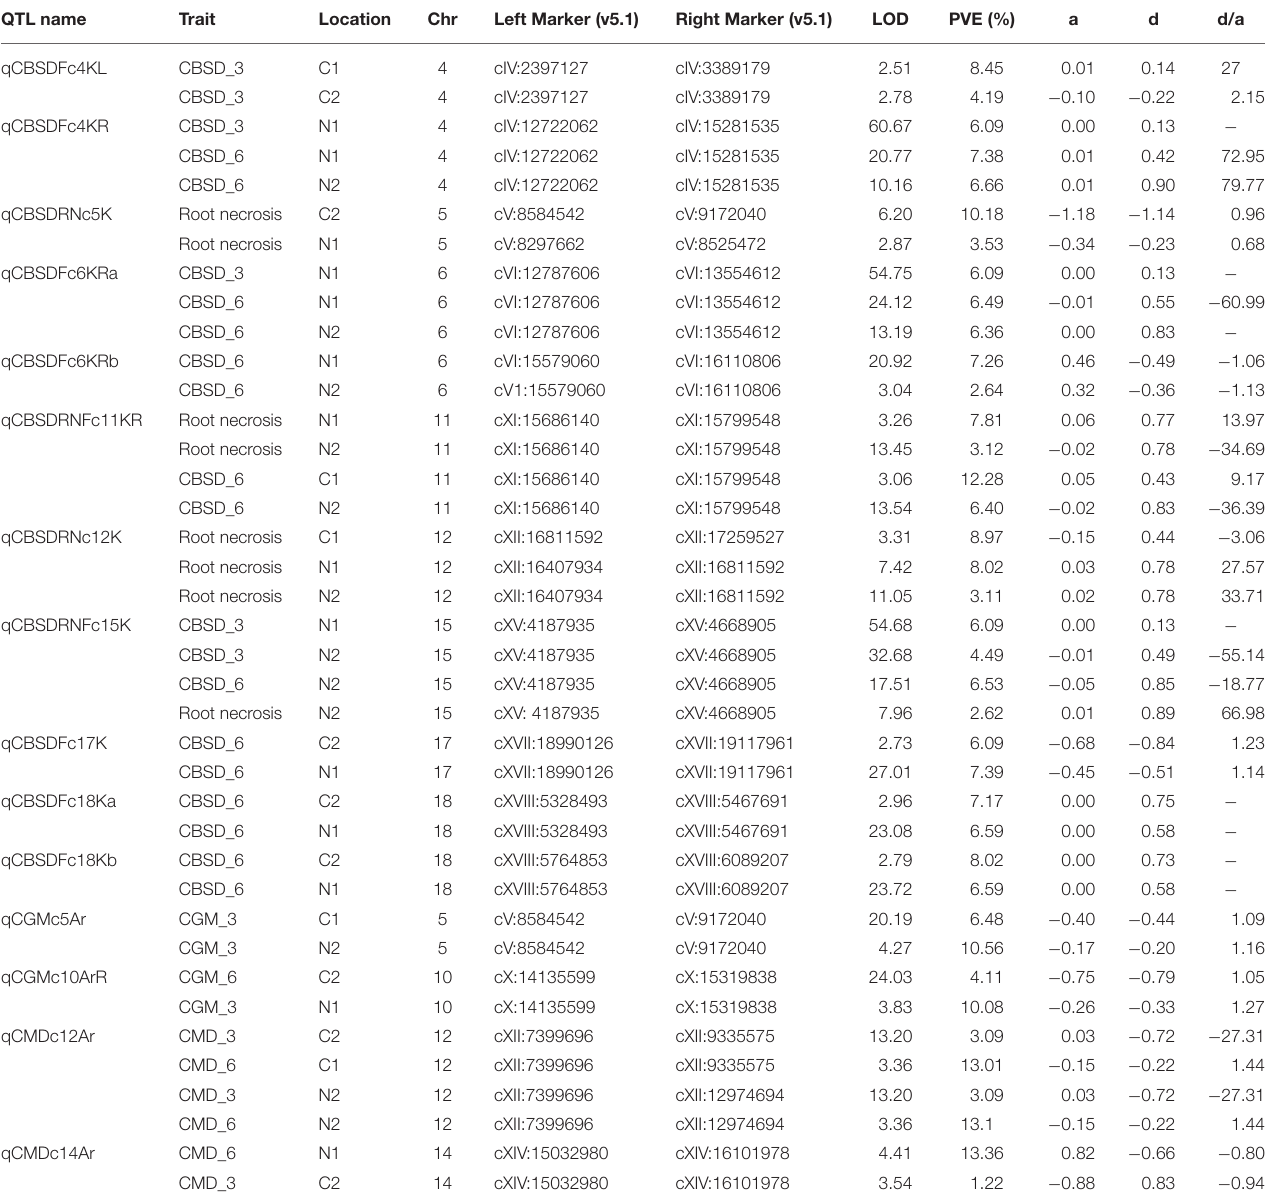
TABLE 3 | Significant QTL detected in Kiroba × AR37-80 mapping